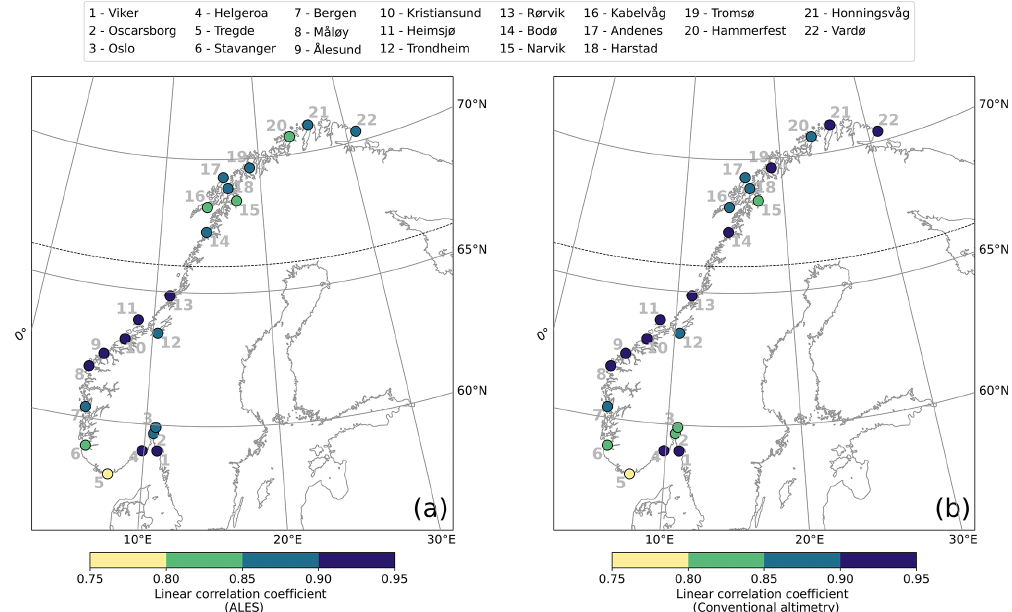
Figure C1. At each tide gauge location, linear correlation coefficient between the detrended, deseasoned monthly mean SLA estimated from the ALES-reprocessed satellite altimetry dataset and from the tide gauge (a) , as well as from the conventional altimetry dataset and from the tide gauge (b) . The black dashed line indicates the 66 ◦ N